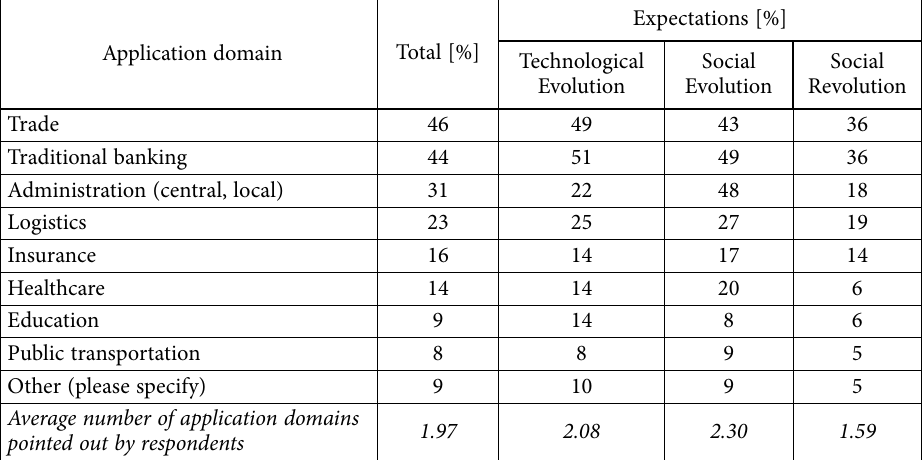
Table 8. Application domain in relation to